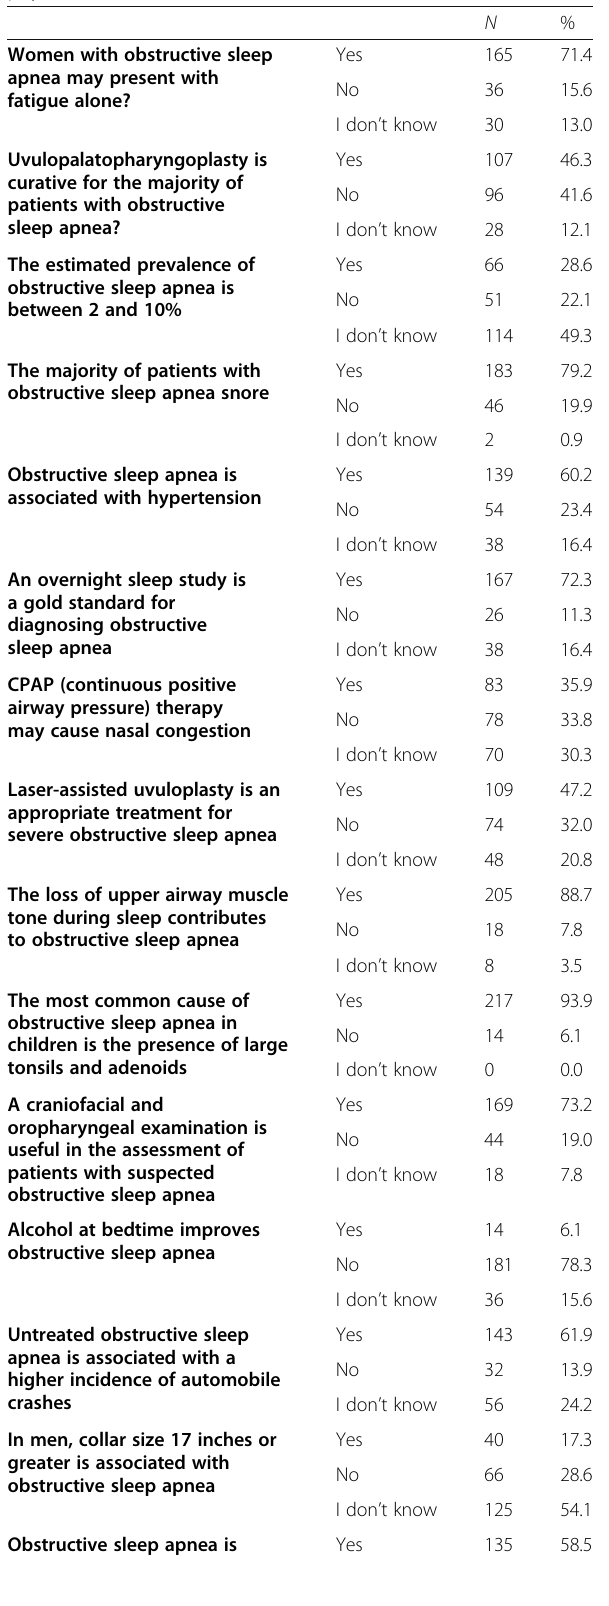
Table 2 Obstructive sleep apnea knowledge among all studied physicians (no. = 231)